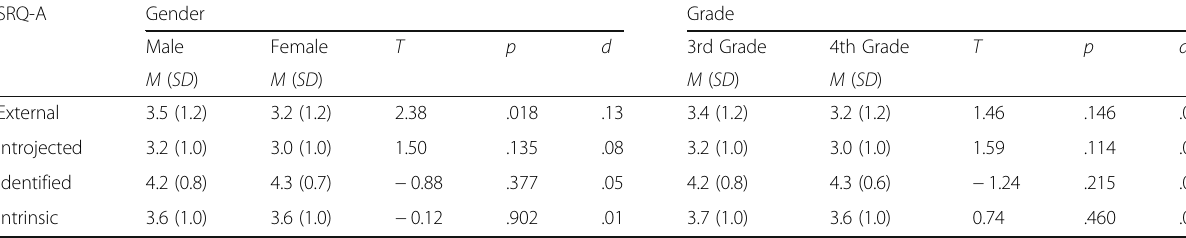
Table 5 Mean and standard deviation by gender and grade